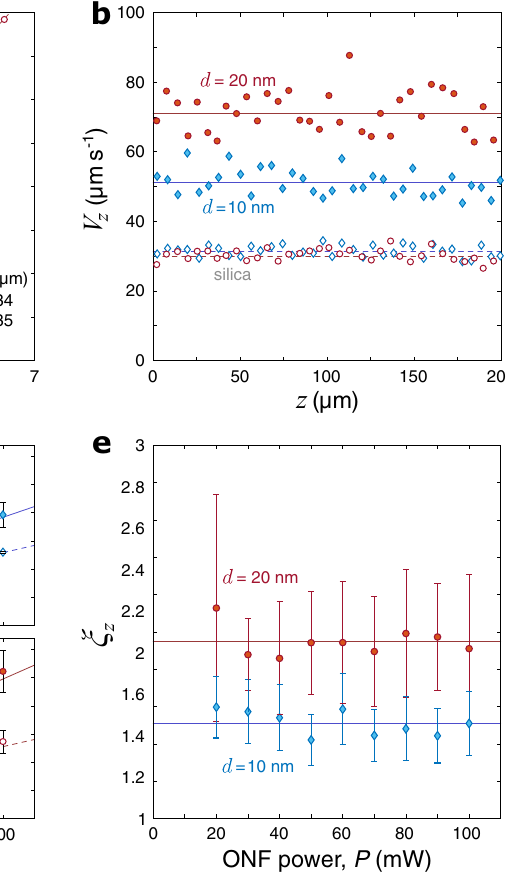
units of μ m s − 1 ): 〈 V JP, z 〉 ∣ ONF1 =51.1, 〈 V SP, z 〉 ∣ ONF1 =31.4, 〈 V JP, z 〉 ∣ ONF2 =71.1, and 〉 ∣ V z , is proportional to the transmitted 〈 V SP, z ONF2 =30.0. c , d Propulsion speed, optical power. e Propulsion enhancement factors, ξ z , are nearly constant throughout the explored range of power, averaging at (horizontal lines) 1.51±0.16 and1.95±0.34for10-nm-and20-nm-thickcoating,respectively.Markersanderror bars in ( c – e ) respectivelyindicate themeanvalues and the 50% standarddeviation ranges obtained for a sample of 5 – 7 different JPs or 2 – 6 different SPs for each power value measured in transmission through the